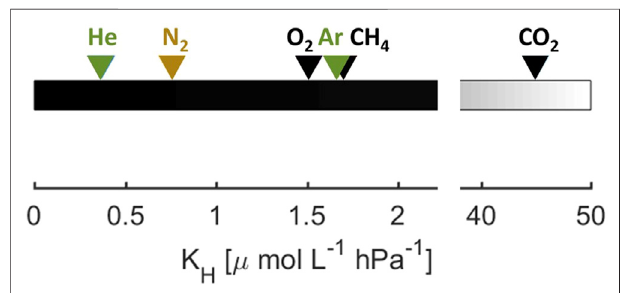
FIGURE 2 | Calculated Henry constants of selected gases for T = 15 ° C and standard pressure. Noble gases are shown in green, biogenic gases and greenhouse gases are shown in black. N 2 is considered as not signi fi cantly altered by metabolism in this study and therefore shown in